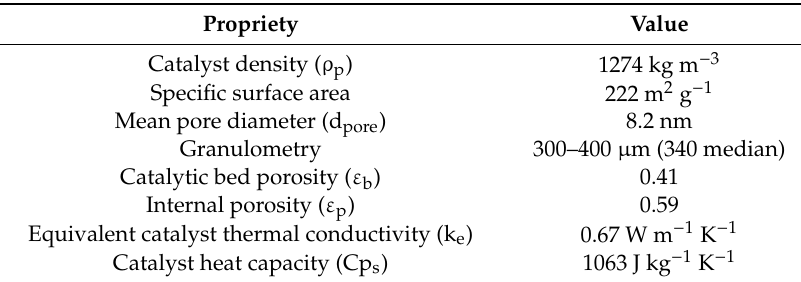
Table 8. Catalyst proprieties.